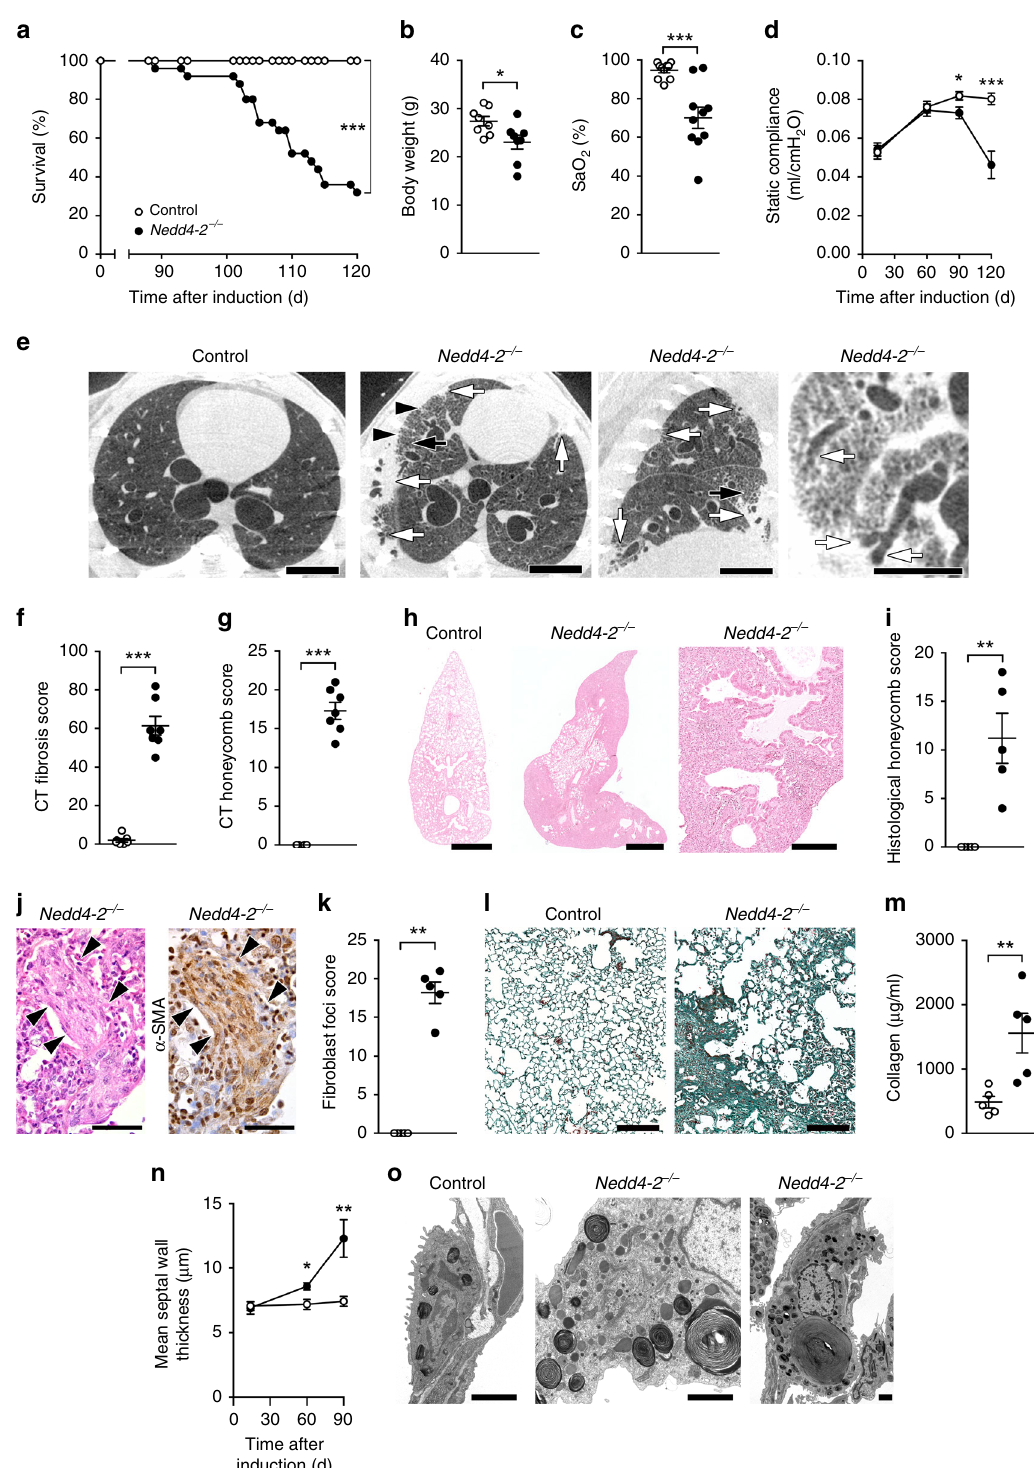
thickening, hypertrophy of AT2 cells, subpleural microscopic honeycombing-like cysts, and Muc5b-positive material within fi brotic areas of the peripheral airspaces (Fig. 2h – n and see below). By transmission electron microscopy we found ultra- structural abnormalities in 15.0 ± 4.5% of all AT2 cells in lung regions that appeared macroscopically normal that were increased to 56.1 ± 9.9% of all AT2 cells in fi brotic regions of